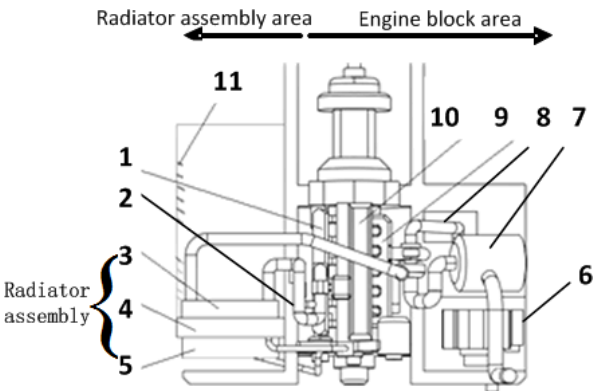
Figure 1. The layout of the typical engine compartment. 1 – intake manifold, 2 – intake baffle, 3 – intercooler, 4 – radiator, 5 – fan, 6 – right outlet, 7 – air compressor, 8 – exhaust pipe, 9 – exhaust manifold, 10 – engine body, 11 – left